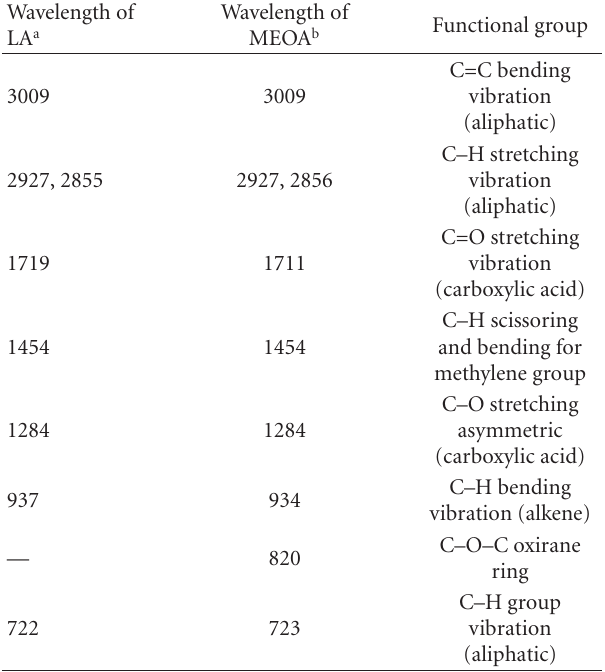
Table 7: The main wavelengths in the FTIR functional groups of LA and